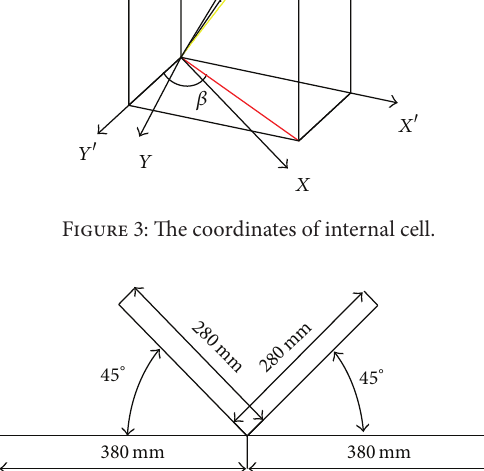
Figure 4: The size of